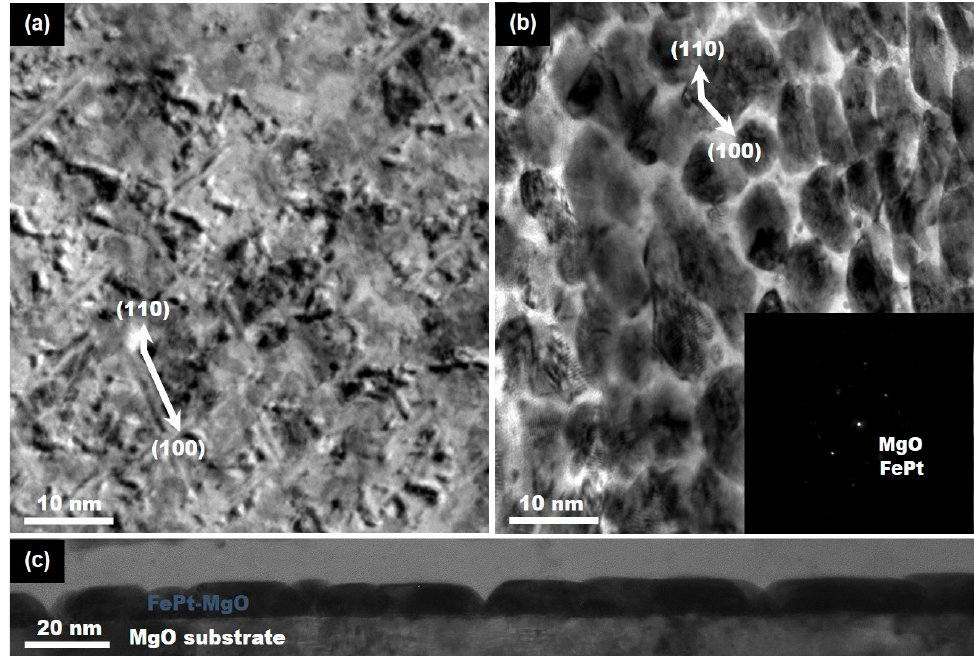
Figure 2. Representative TEM bright-field micrographs for the FePt films ( a ) without and ( b ) with MgO additive nanolayers, and the inset is the corresponding selective electron diffraction pattern (SEDP), respectively. ( c ) is the cross-sectional TEM micrograph for the FePt–MgO composited thin films.